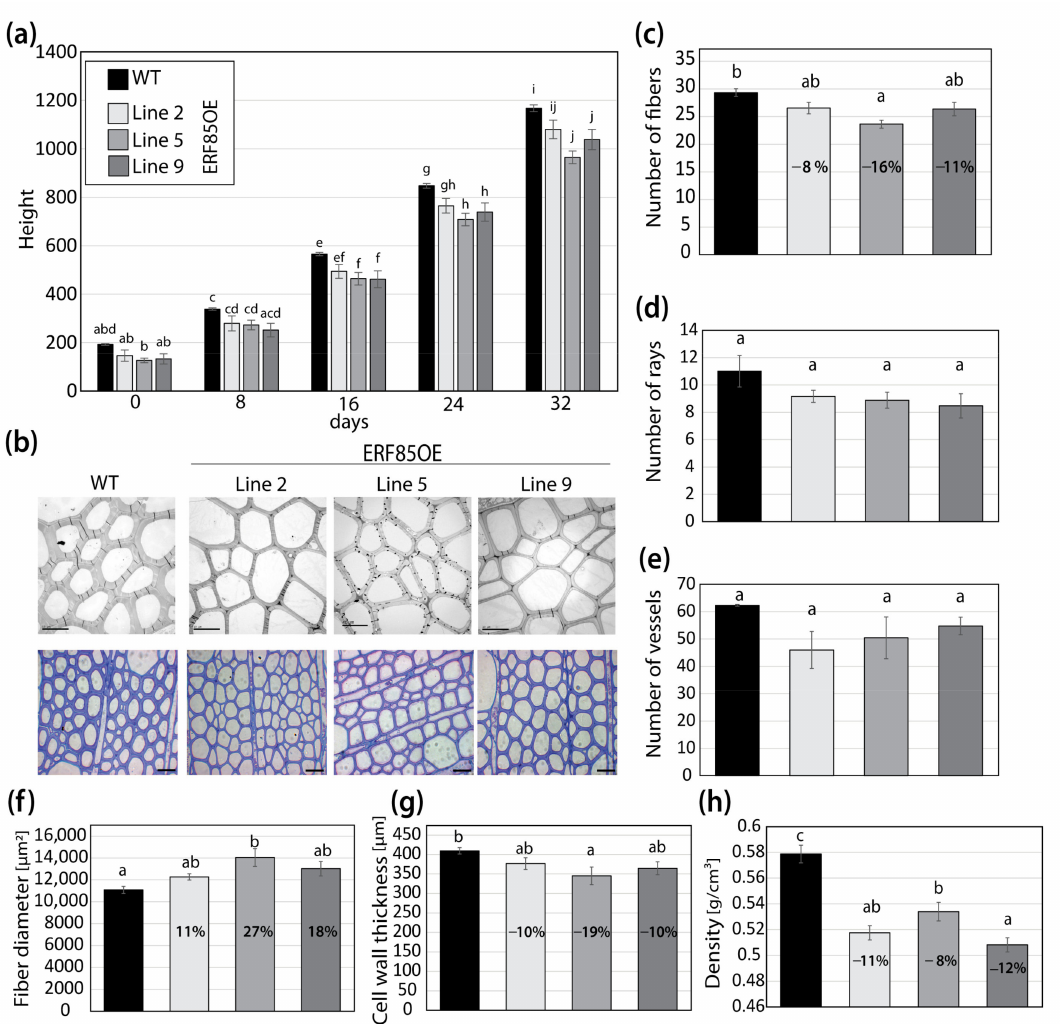
Figure 3. Ectopic expression of PtERF85 in woody tissue increased fibers diameter and reduced cell wall thickness. ( a ) Stem growth rate of WT and three transgenic lines that ectopically express PtERF85 (ERF85OE) under a xylem specific wood promoter ( pLMX5 ; [15]) in a controlled greenhouse environment. ( b ) Transmission electron micrographs (TEM; 100-fold magnification; scale bar is 10 µ m) and toluidine blue staining (20-fold magnification; scale bar is 40 µ m). TEM pictures cover a total area of 149,295 µ m 2 . ( c ) The number of fiber cells counted in toluidine blue cross-sections is shown in ( b ). ( d , e ) Numbers of ray and vessel cells (in an area of 3.02 mm 2 ) in WT and ERF85OE lines. Cross-sections used for quantification are shown in Figure S3b. ( f ) Fiber diameter from toluidine blue-stained cross-sections is shown in ( b ). Cell outlines were defined by the middle lamella and the enclosed area [ µ m 2 ] was measured using ImageJ. ( g ) Cell wall thickness (determined as the lumen-to-lumen distance of two neighboring cells [ µ m]) based on toluidine blue-stained stem sections (shown in ( b )), using a 100-fold magnification. ( h ) Wood density. For all panels, bars represent mean ± SE calculated from three biological replicates per line using a linear effect model. Significant differences between genotypes were indicated by the unique occurrence of letters above the bars and were assigned based on multiple comparison tests and a p -value <